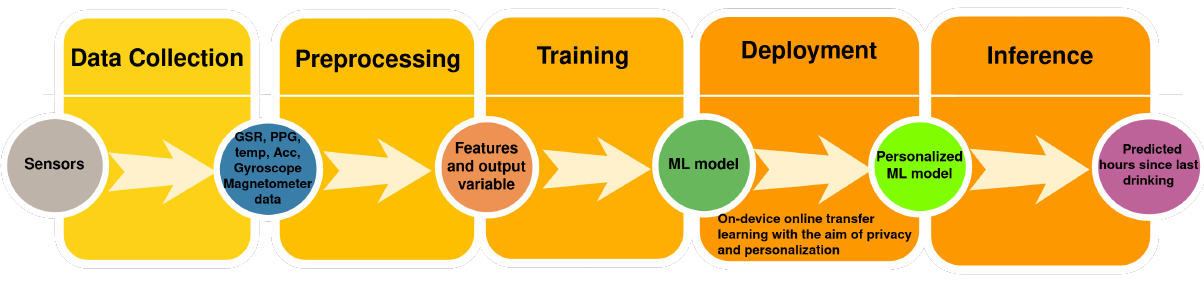
Figure 1. Pipeline for on-device personalized private learning for dehydration